Question: What form of chart is displayed?
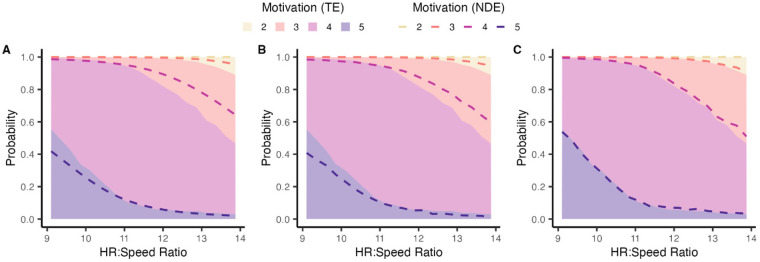
Answer: line